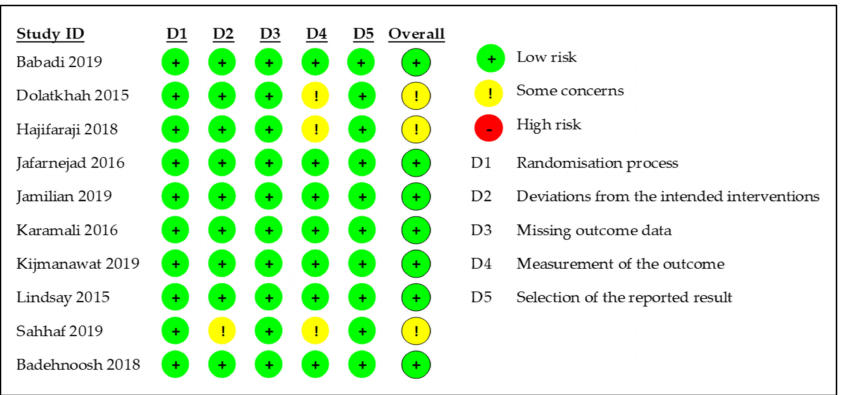
Figure 2. Risk of bias summary: reviewers’ judgement on the risk of bias item for included studies. Green symbol represents low risk of bias (RoB), yellow symbol represents unclear RoB, and red symbol represents high